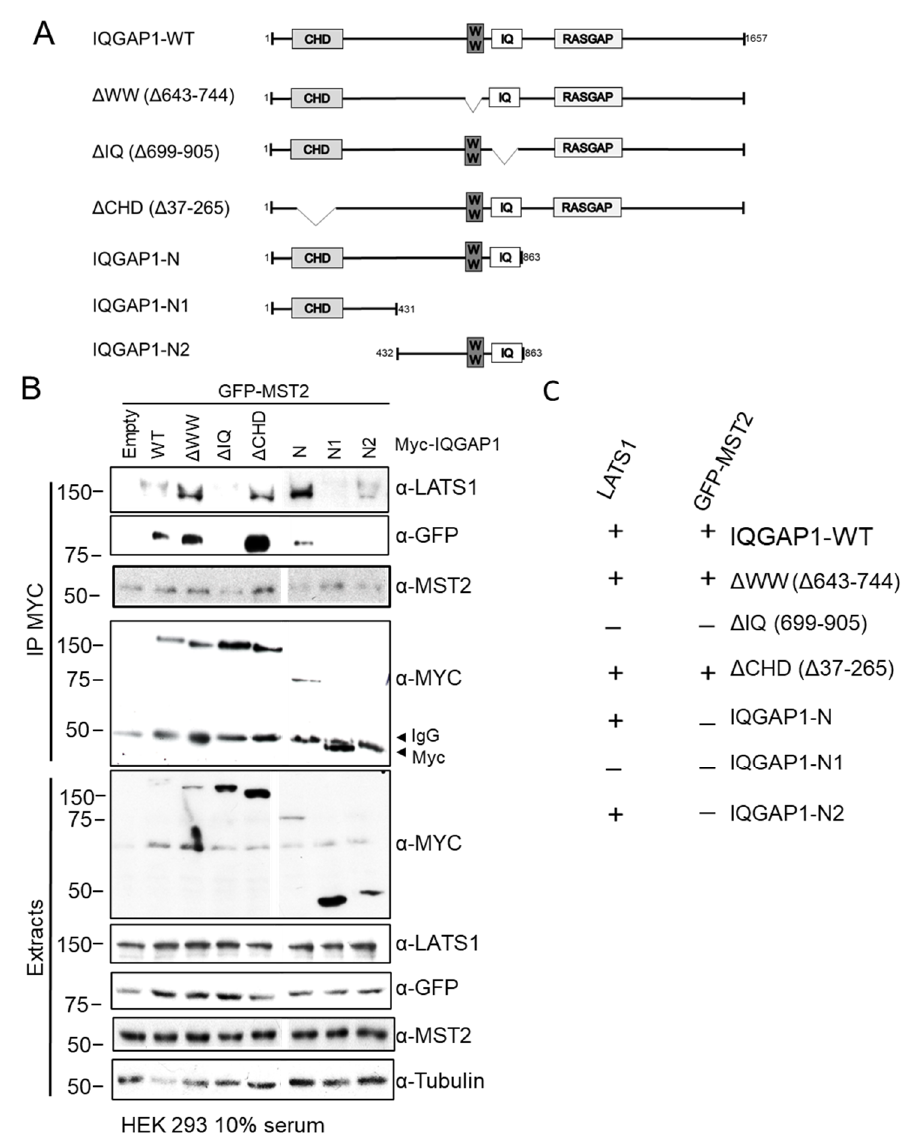
Figure 3. LATS1 and MST2 bind to IQGAP1 IQ domains. ( A ) A schematic representation of IQGAP1 full length and domain deletion mutants of IQGAP1. The protein interaction domains and the amino acid residues of each mutant are indicated. IQGAP1 Myc-tagged constructs used were wild-type IQGAP1 (WT), IQGAP1 ∆ WW ( ∆ WW), IQGAP1 ∆ IQ ( ∆ IQ), IQGAP1 ∆ CHD ( ∆ CHD), IQGAP1-N (N), IQGAP1-N1 (N1) or IQGAP1-N2 (N2). ( B ) HEK 293 cells were co-transfected with different Myc-IQGAP1 (2 µ g) tagged deletion constructs and with GFP-MST2 (1 µ g). Myc-IQGAP1 immunoprecipitates were analysed by western blotting with indicated antibodies. IgG heavy chain unspecific band and Myc specific band (~50 KDa) are indicated with (cid:74) . All blots were spliced from the same blots and a gap has been left to make this clear. ( C ) Table summarises the ability of LATS1 and MST2 to bind (+) or not ( − ) to IQGAP1